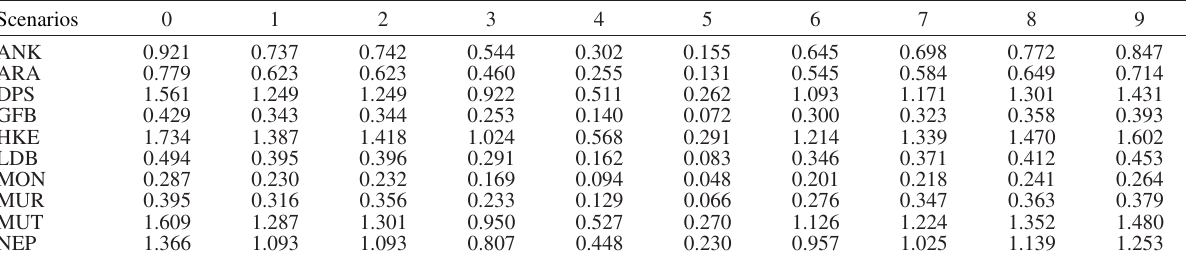
Table 8. – F by stock under the nine scenarios considered after five consecutive years of implementation of the measures of fishing effort bar reduction. Definition of the scenarios in Table 6 and species codes as in Table 1.